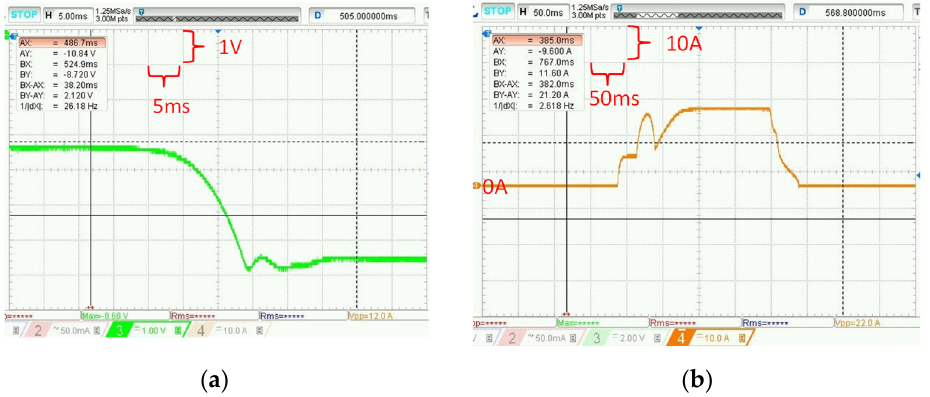
Figure 14. The closing dynamic characteristics of the prototype. ( a ) The mover position in closing process. ( b ) The current in closing coil.